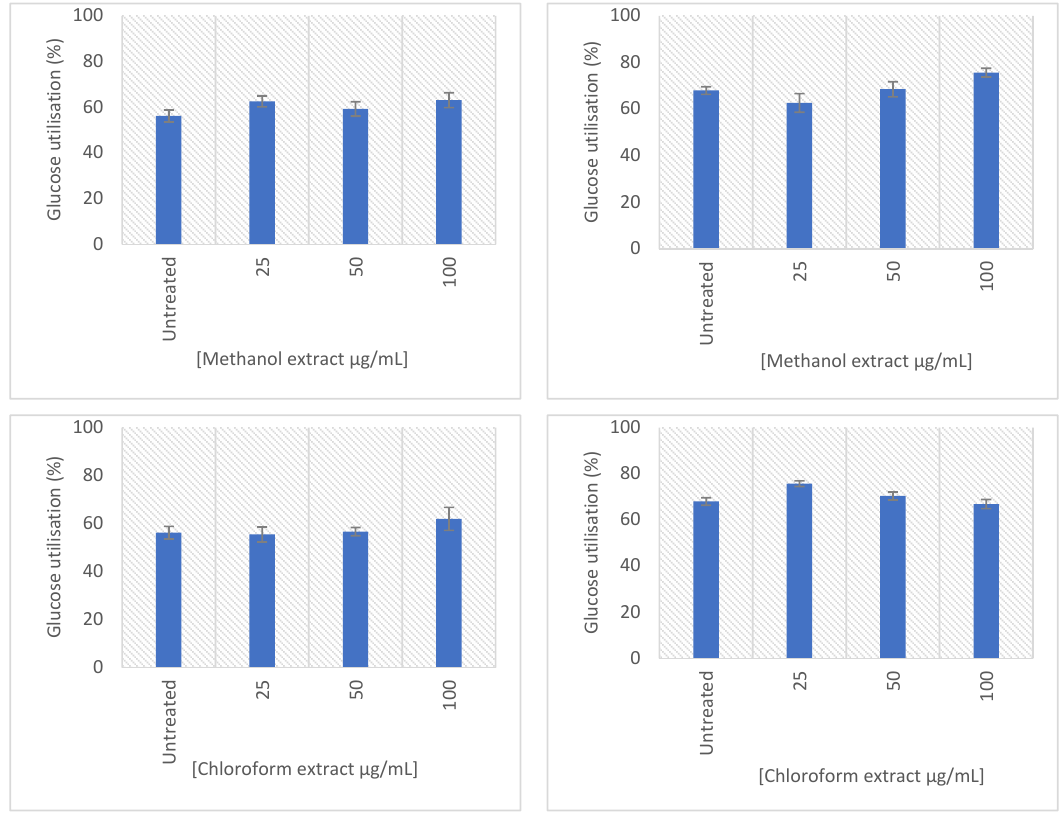
Figure 6. Glucose utilization (%) after 24 h of treatment in the L6 myoblasts ( left ) and the C3A hepatocytes ( right ). Results were normalized to the cell viability, as determined using the MTT assay. Error bars indicate the standard deviation of the mean of four replicates from a single experiment.